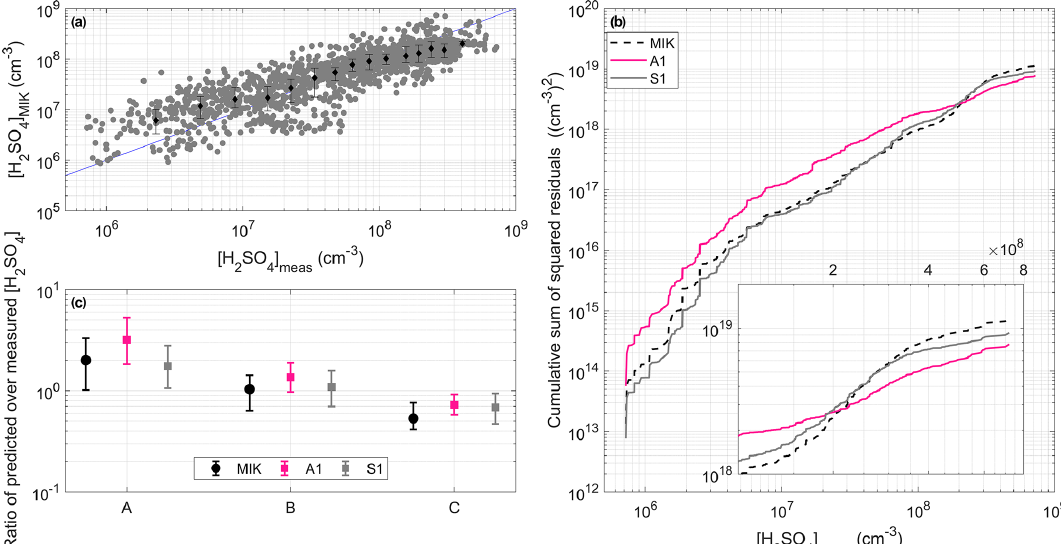
Figure 6. Comparison between the results obtained with MIK and the predictions derived from A1 and S1. (a) Predictions retrieved by MIK as a function of measured [H 2 SO 4 ]. The data points were also divided into 15bins with an equal number of data points based on measured [H 2 SO 4 ]. The medians (markers) and the 25th and 75th percentiles (error bars) of [H 2 SO 4 ] predicted in each bin are also shown. (b) Cumulative sum of squared residuals associated with MIK, A1 and S1. The insert presents a zoomed in section of the re- sults obtained for [H 2 SO 4 ] > 1 × 10 8 cm − 3 . (c) Ratio between predicted and measured [H 2 SO 4 ] in the different [H 2 SO 4 ] subranges, with A corresponding to [H 2 SO 4 ] < 2 × 10 7 cm − 3 , B corresponding to [H 2 SO 4 ] between 2 × 10 7 and 2 × 10 8 cm − 3 , and C corresponding to [H 2 SO 4 ] > 2 × 10 8 cm − 3 . For each proxy, the marker represents the median of the ratio, and the lower and upper limits of the error bars indicate the 25th and 75th percentiles respectively.